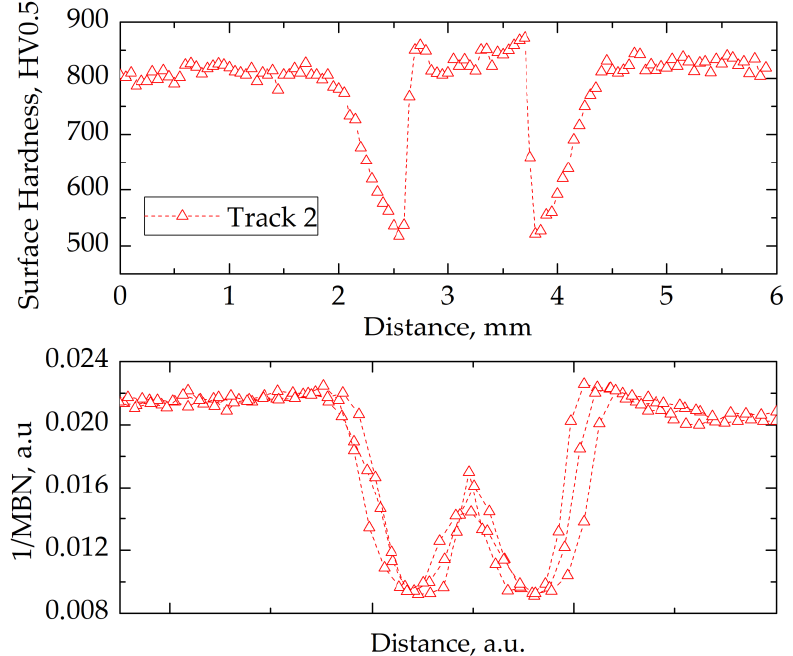
Figure 11. Relation between hardness (upper panel) and normalized 1/MBN (lower panel) as a function of distance (surface coordinate) across the laser-processed track 2.